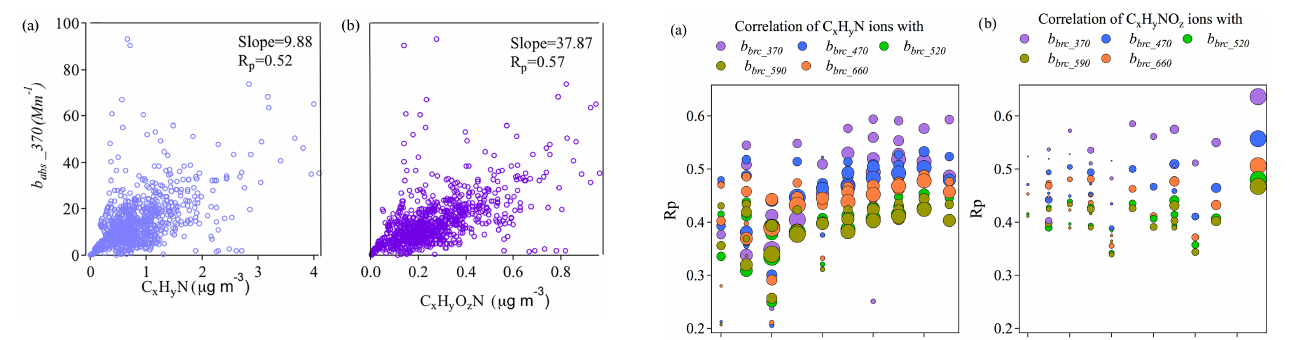
Figure 6. Correlations between BrC absorption coefficients at 370nm and mass concentrations of N-containing organic ion fami- lies.